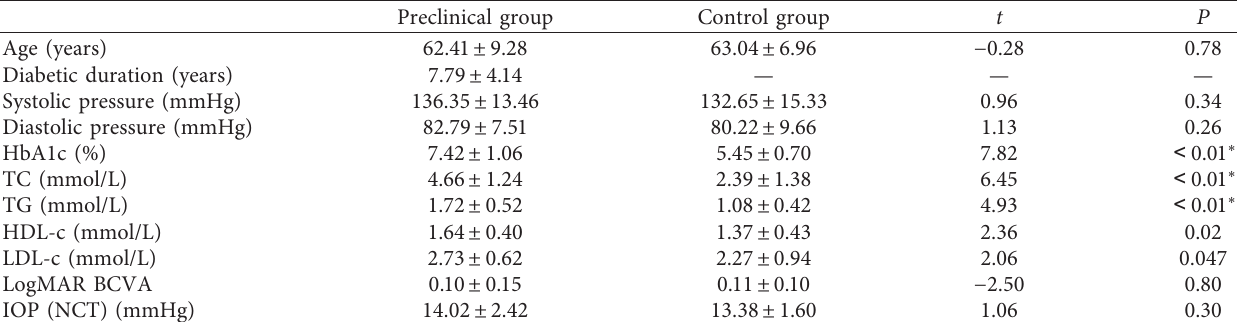
Table 1: Demographic and clinical characteristics of the study